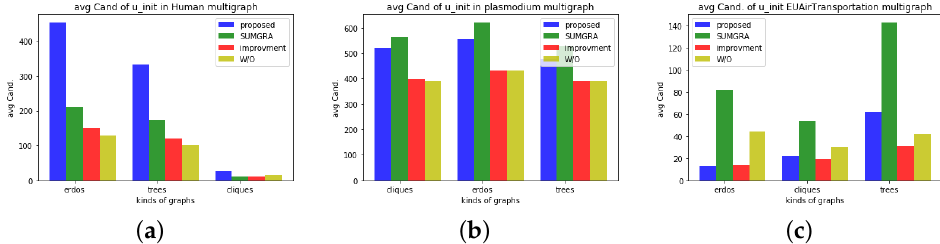
Figure 8. avg size of C uinit on ( a ) humanHIV dataset, ( b ) plasmodium dataset and ( c ) EUAir dataset.